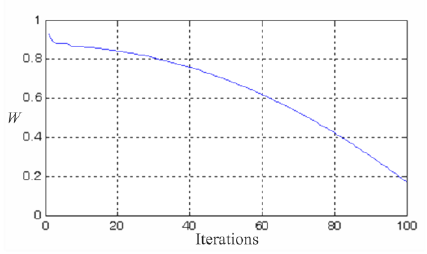
Figure 4. Trends of the weighting value ( W ) of the modified particle swarm optimization (PSO). Table 1. Weighting value adjustment according to the slope and changes in power of the characteristic curve.